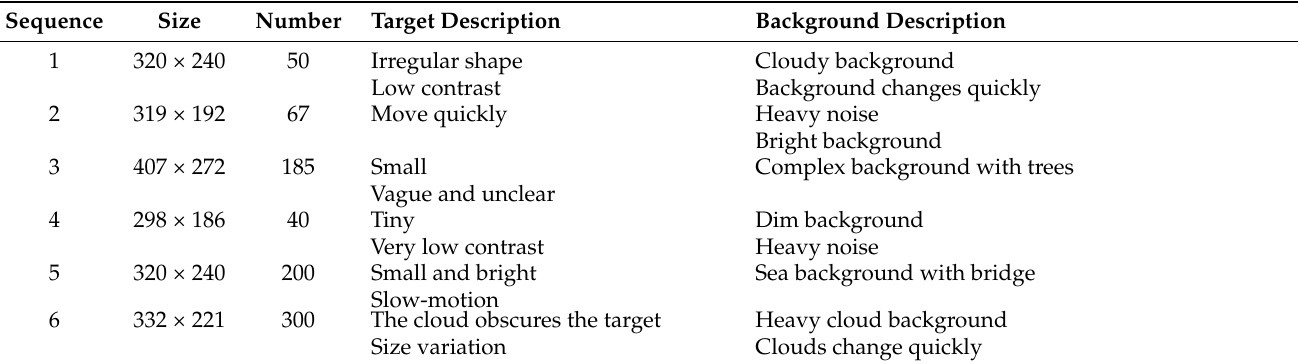
Table 1. The specific information of the six image